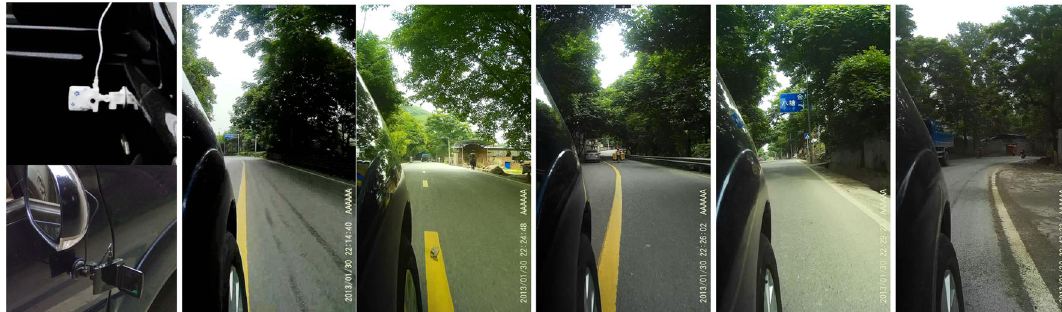
Fig. 5 Using the position of right tire on the pavement to determine the lateral position of the test